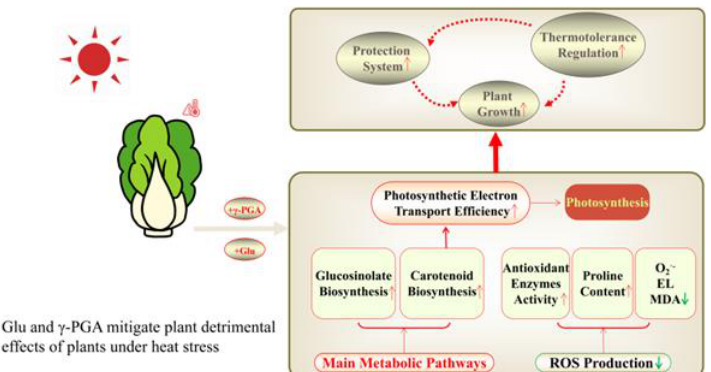
Figure 7. Schematic summary of Glu- and γ -PGA-primed physiological status for the preadaptation to heat stress in Chinese cabbage seedlings. The solid arrows represent enhancement, whereas the dotted arrows represent